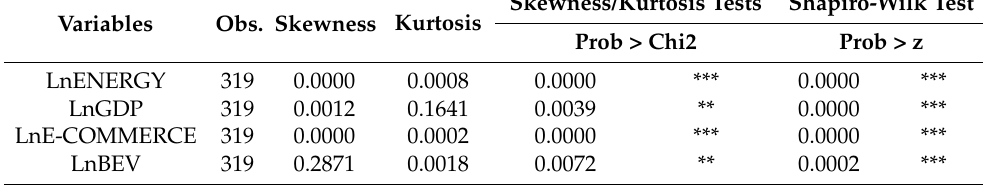
Table 4. Normal distribution